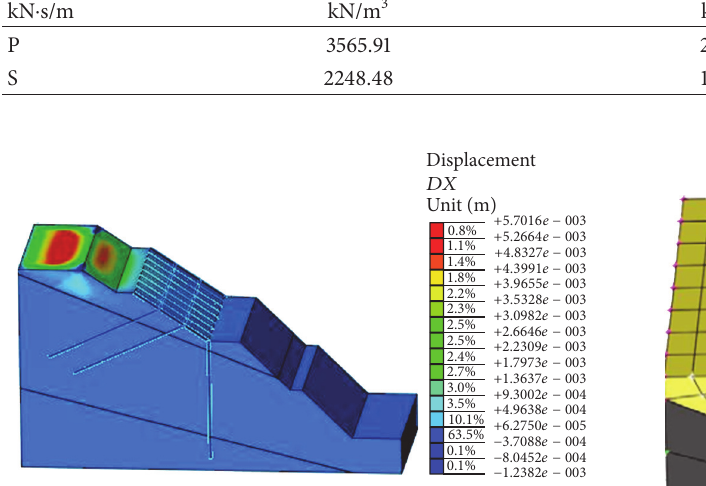
Figure 7: Sine load horizontal displacement analysis cloud picture.